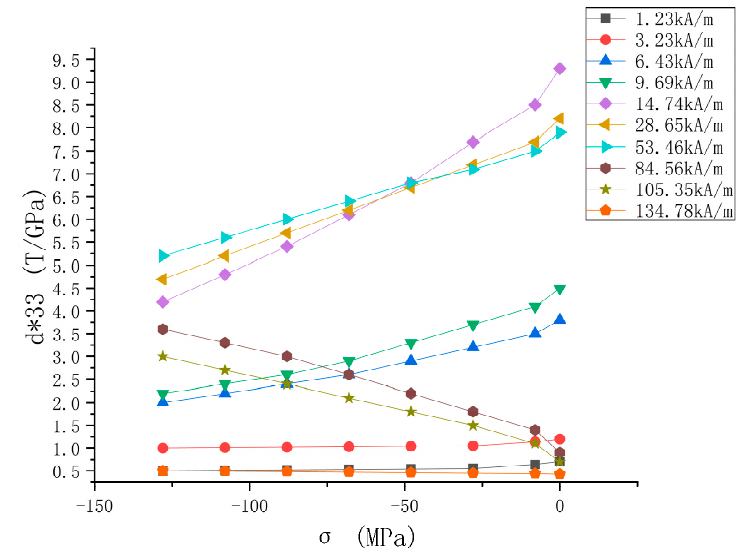
Figure 5. Relationship between piezomagnetic coefficient and compressive stress under different bias magnetic fields.